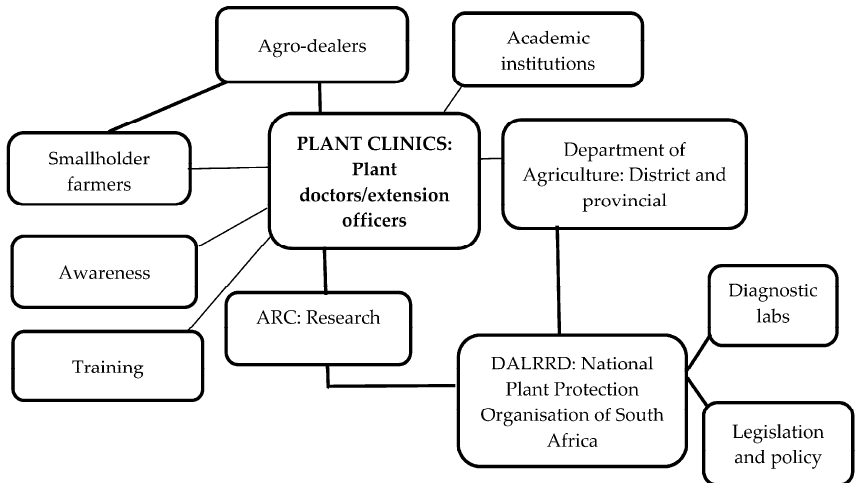
Figure 3. Proposed plant clinic framework in the Vhembe District Municipality, Limpopo